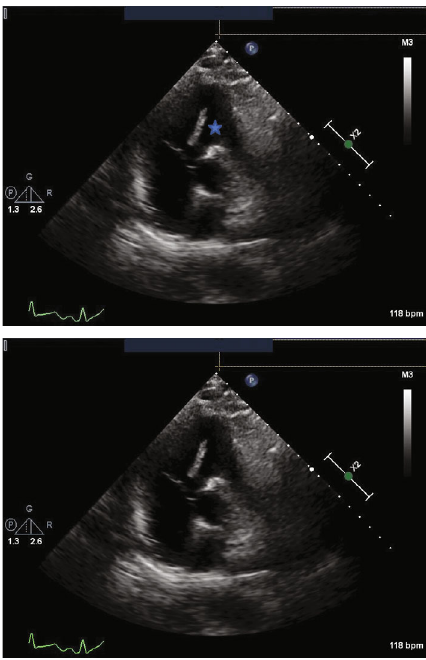
Figure 4: Echocardiogram in the short axis view showing the clot in transit in the right ventricle